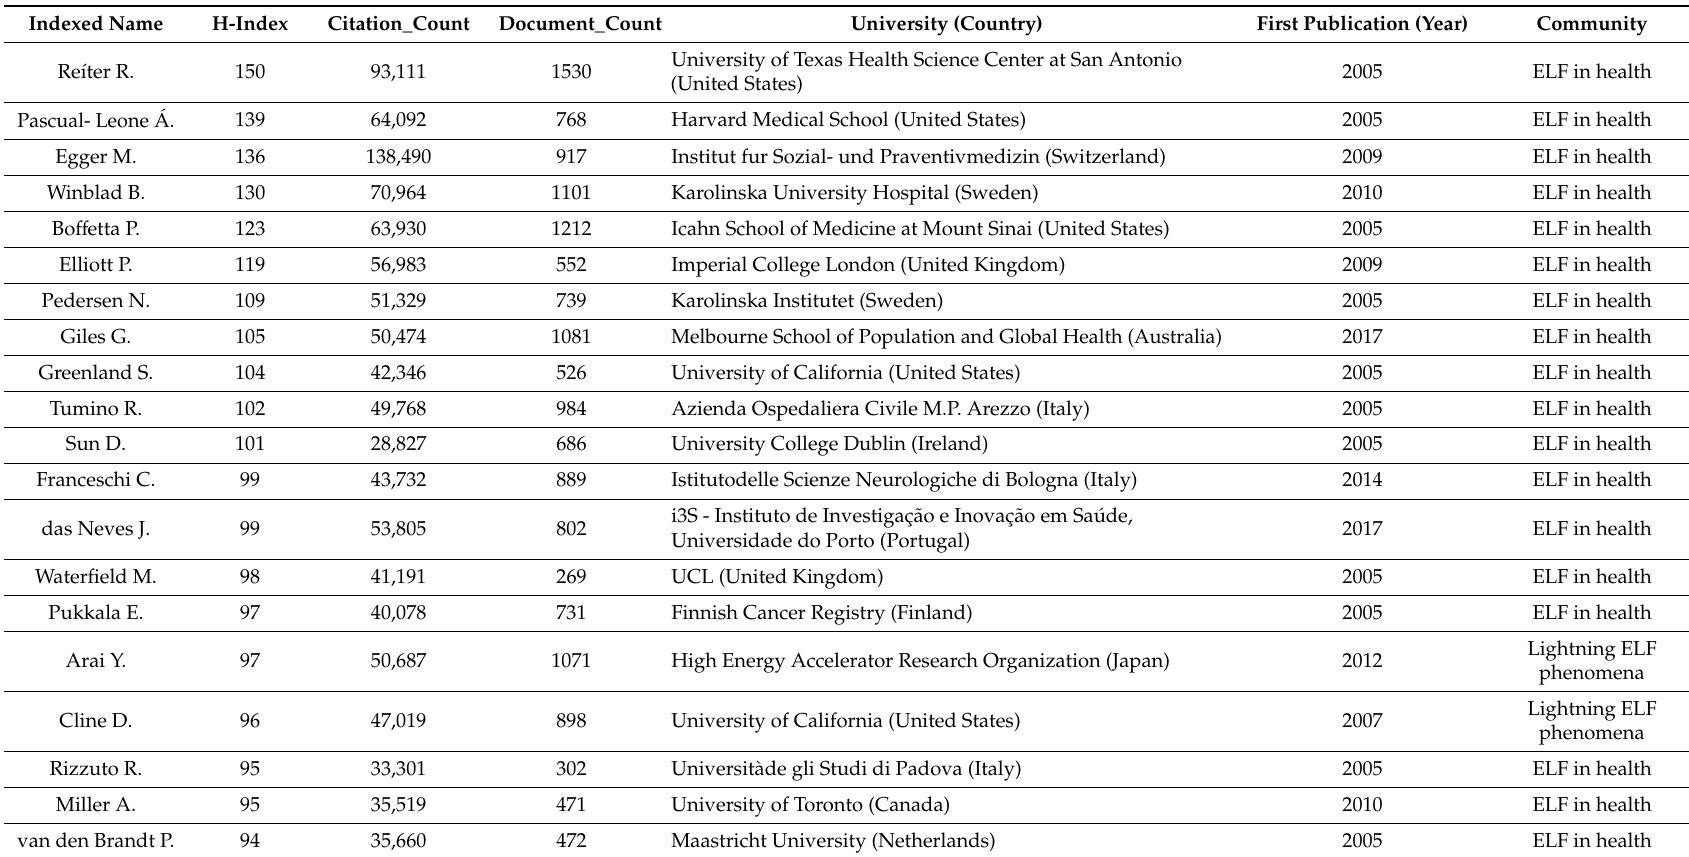
Table 1. Top 20 most-important authors by